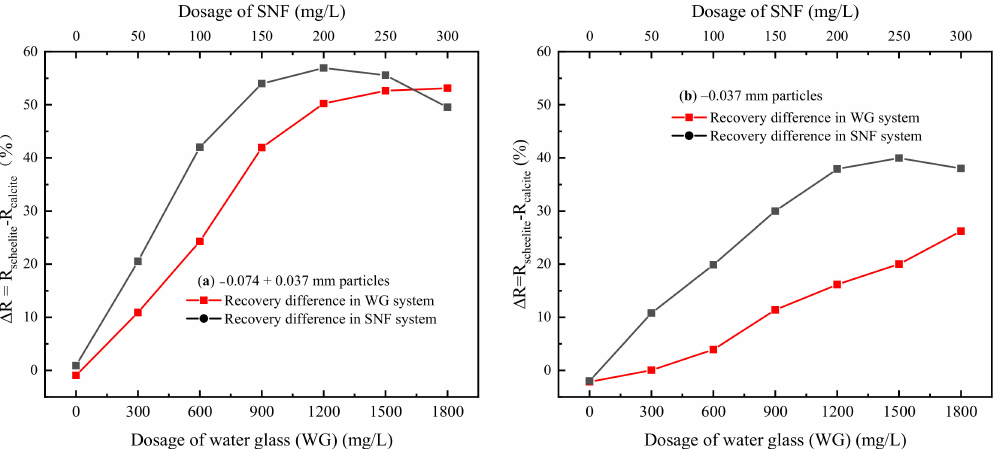
Figure 5. Effects of the depressant dosage on the floatability deference between scheelite and calcite with size fractions of − 0.074 + 0.037 mm ( a ) and − 0.037 mm ( b ) (C NaOL = 50 mg/L, pH ≈